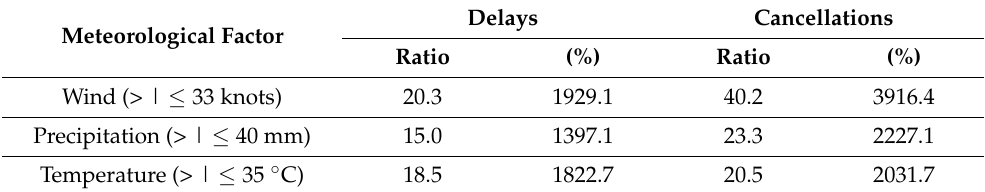
Table 4. Comparison of average delays/cancellations affected by a meteorological factor.